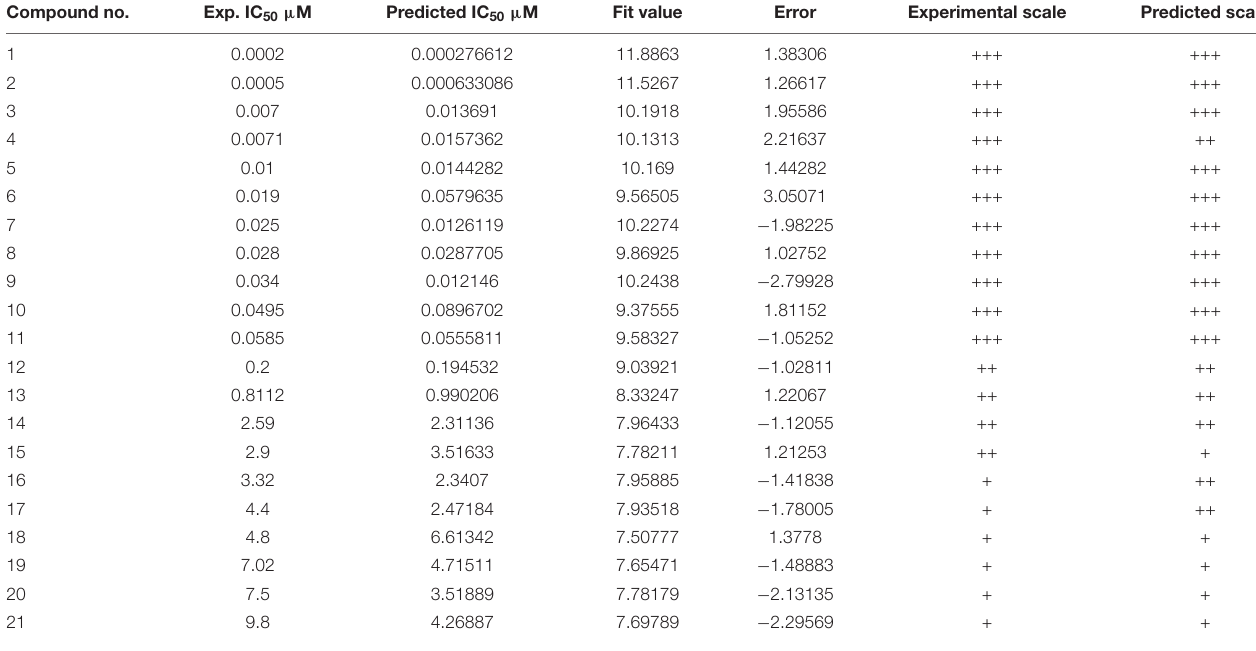
TABLE 1 | Actual and estimated efficacies of the training set molecules based on the Hypogen1 model. Compound